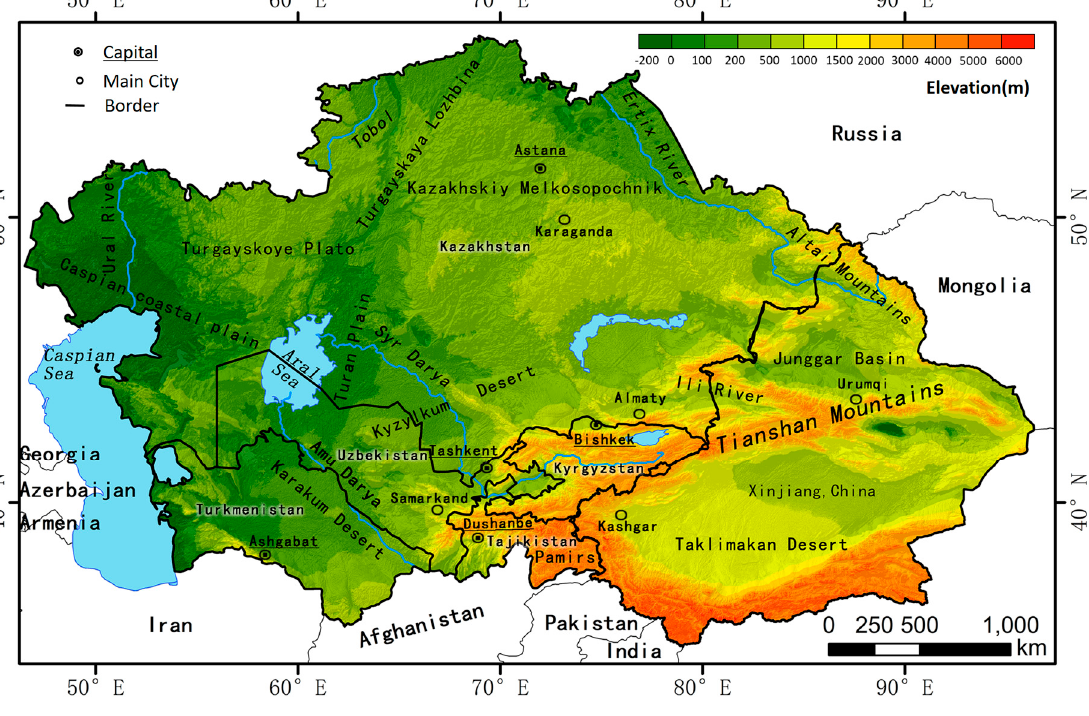
Figure 1. Study area showing relatively flat regions in the northwestern part of Central Asia and high elevations in the southeast mountainous regions.